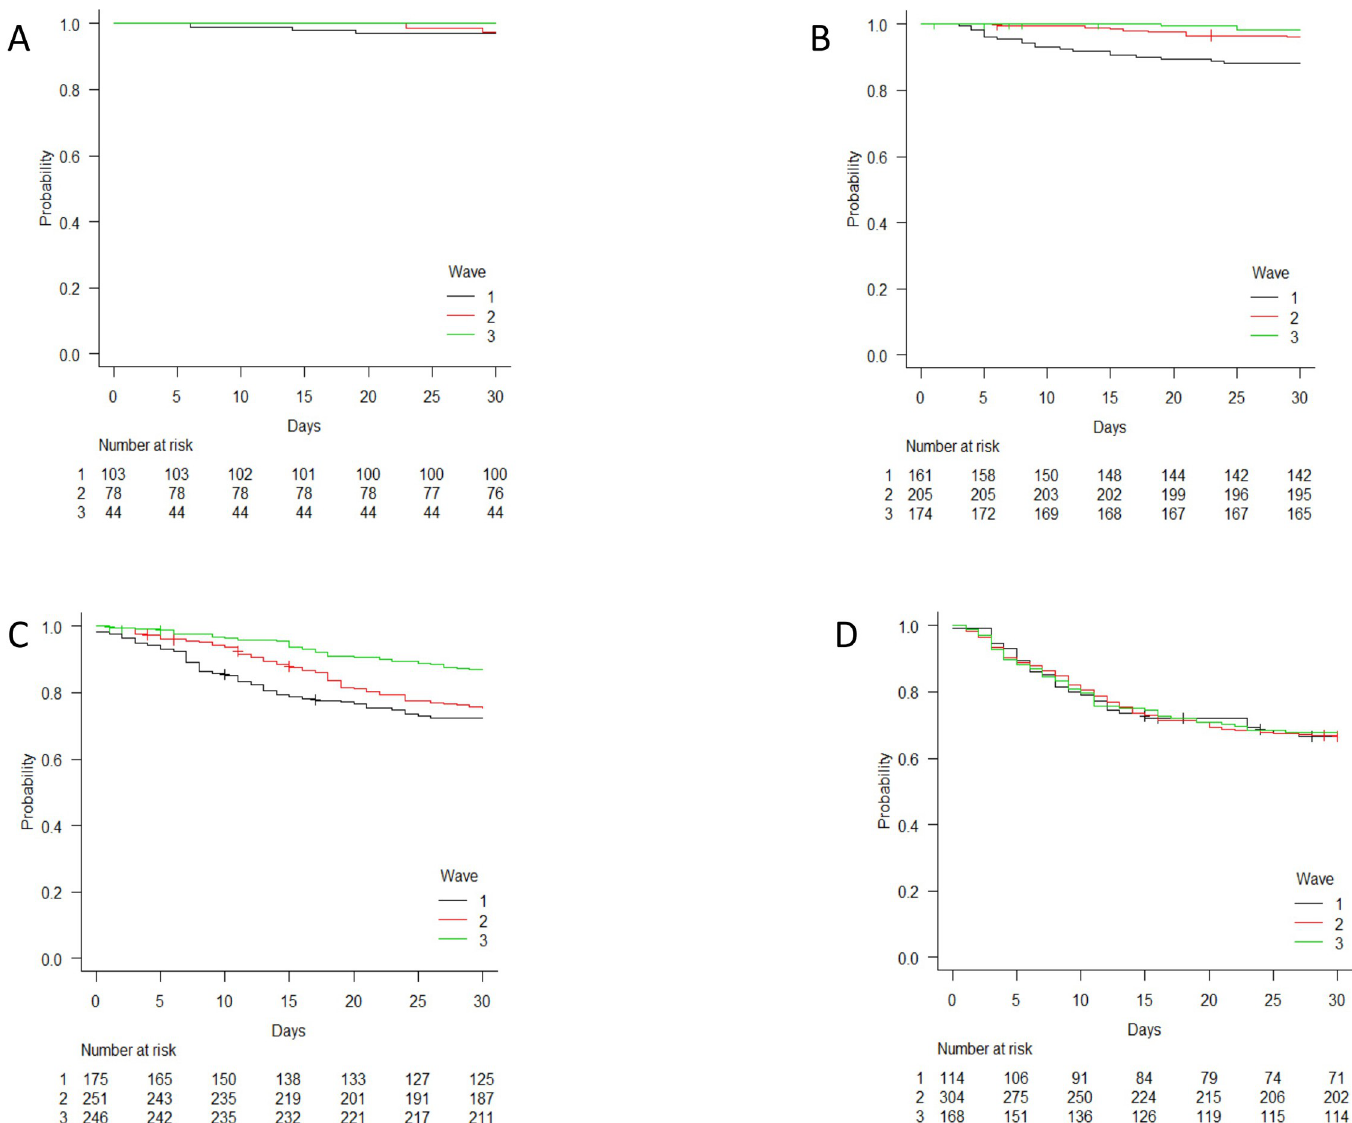
Fig 2. Time-dependent survival probability by period of hospital admission (wave 1 [February-July 2020], wave 2 [August 2020-January 2021], and wave 3 [February-April 2021]) stratified by age: A � 45 years; B 46–60 years; C 61–75; and D > 75 years.